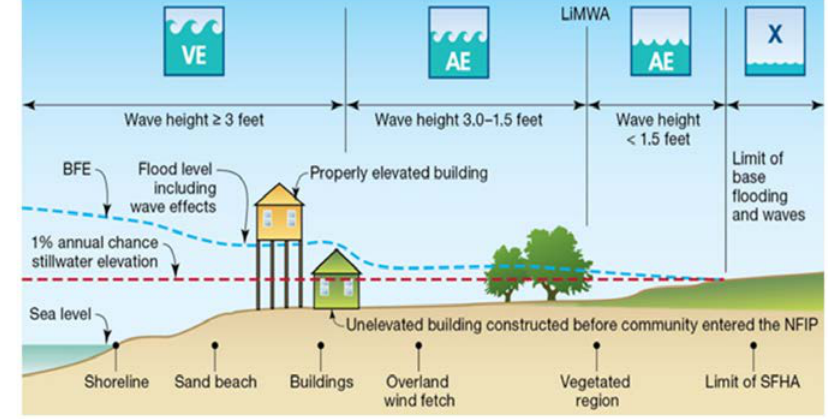
Figure 1. FEMA flood zone map definitions. Dashed red line is the 1% inundation level and the dashed blue line is the base flood elevation (BFE). These can be referenced to as either grade elevation or NAVD88 benchmarks. Zone definitions are provided at the top of the figure (VE, AE, LIMWA, and X). (http://www.r3coastal.com/home/coastal-hazard-analysis-mapping/coastal-flood-hazard- mapping, accessed on 11 February 2020). (Definition of the flood zones are provided at https://www.fema.gov/flood-zones, accessed on 16 April 2020.)